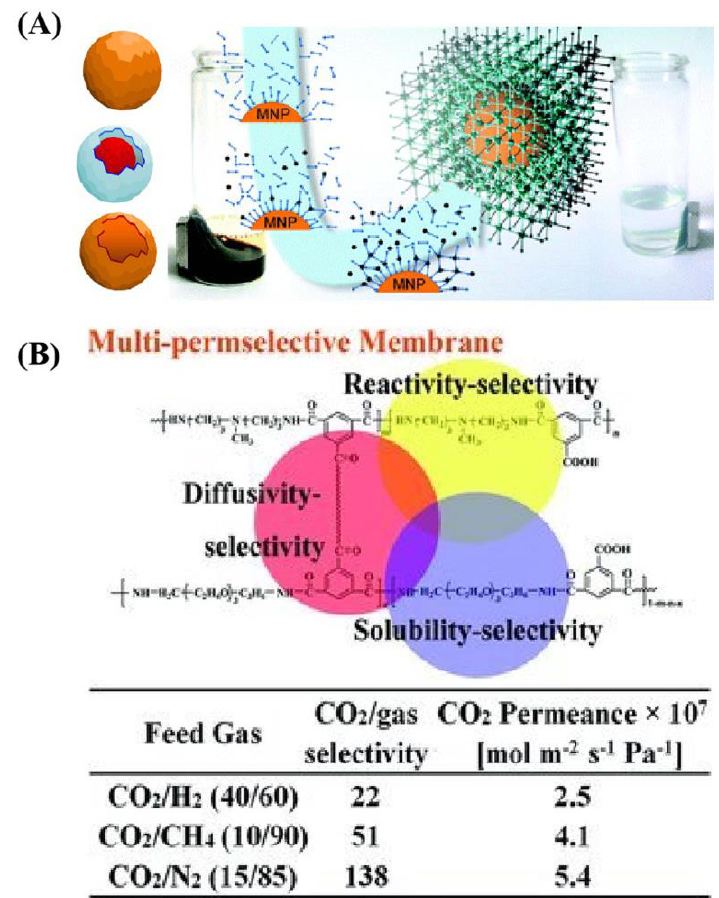
Figure 5. ( A ) Schematic illustration of MMOF by using different structural magnetic composites; ( B ) High-performance membranes with multi-permselectivity for CO 2 separation. These are reprinted with permission from Lohe et al. (2011, RSC) and Li et al. (2012,